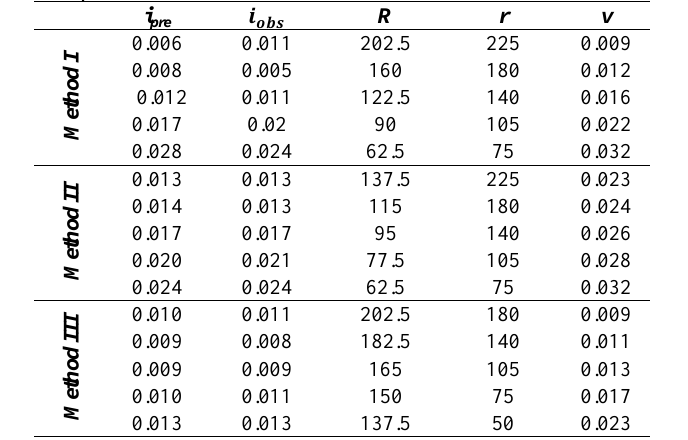
Table 8. The values of i predicted by the Method I , II, III in the depth of 85 and level of 20 pre